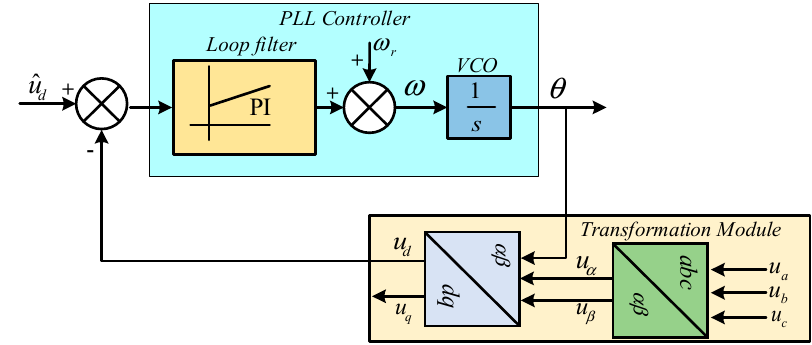
Figure 18. General schematic of a three-phase PLL technique.